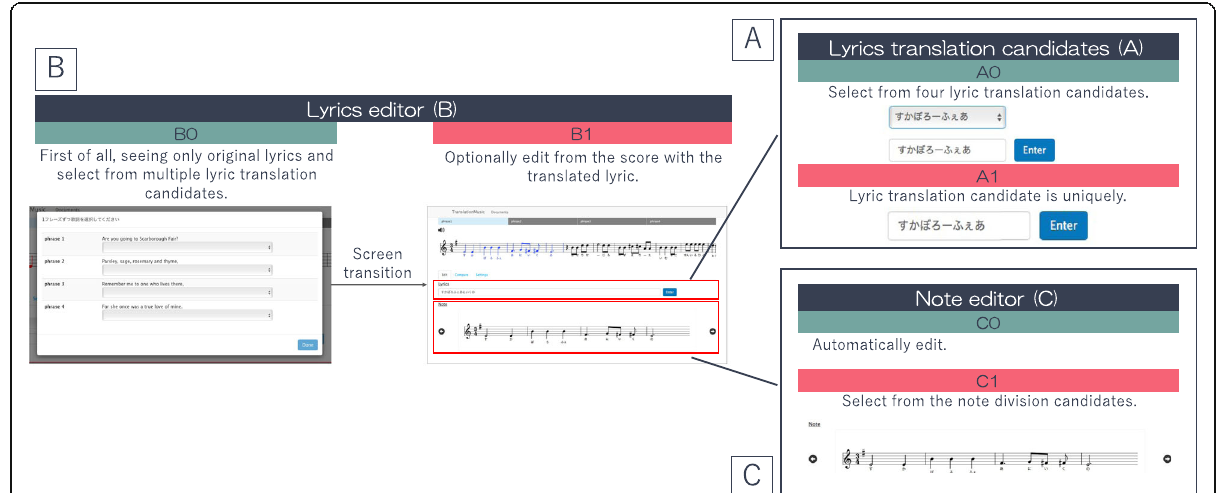
Fig. 4 Interface functions. (arranged from ref.